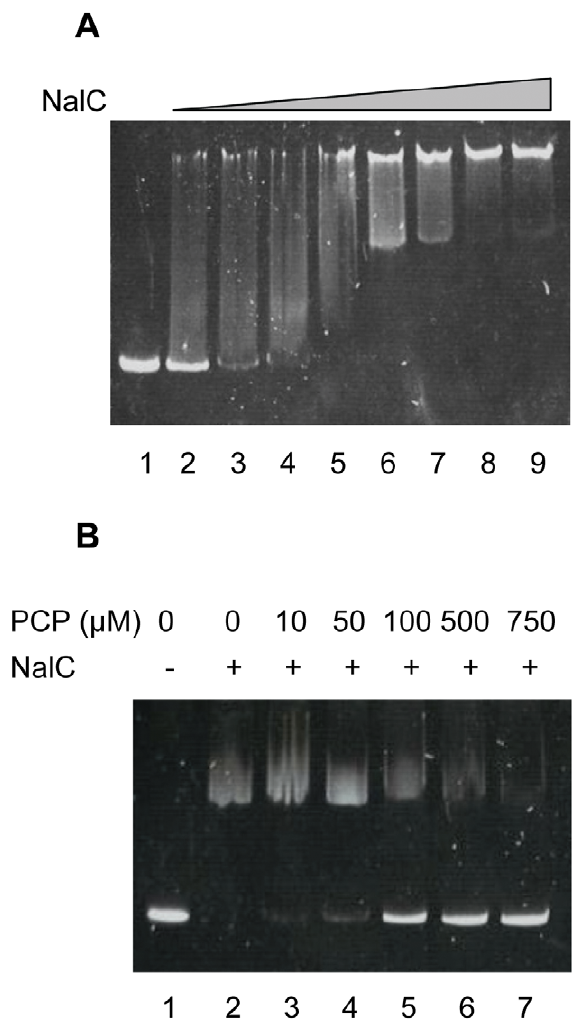
Figure 2. PCP modulation of NalC repressor binding to the PA3720- armR upstream region. A) Mobility shift assay in which 50 ng of a 209-bp DNA fragment encompassing the nalC -PA3720 intergenic region was incubated without (lane 1) or with 200 (lane 2), 300 (lane 3), 400 (lane 4), 500 (lane 5), 800 (lane 6), 1000 (lane 7), 2000 (lane 8) or 3000 (lane 9) ng of purified NalC-His. B) Mobility shift assay in which purified NalC-His (800 ng) was incubated with 50 ng of a 209-bp DNA fragment encompassing the nalC -PA3720 intergenic region and increasing amounts of PCP as indicated. Lane 1, DNA only control.